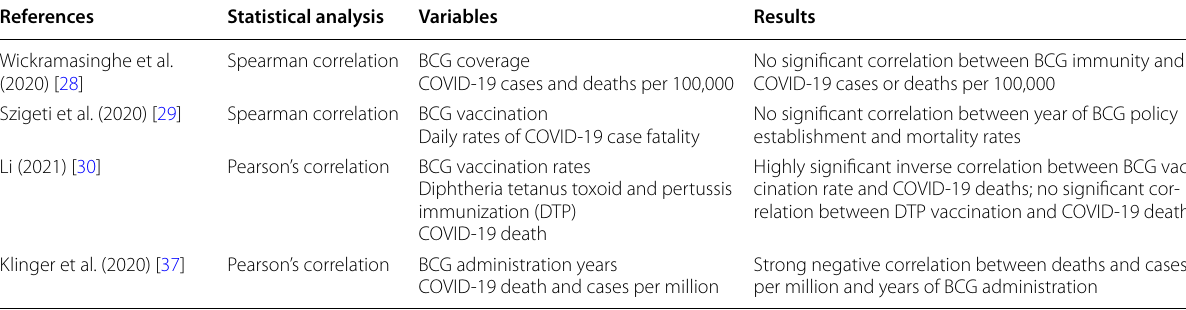
Table 3 Effects of BCG Vaccination on morbidity and mortality based on